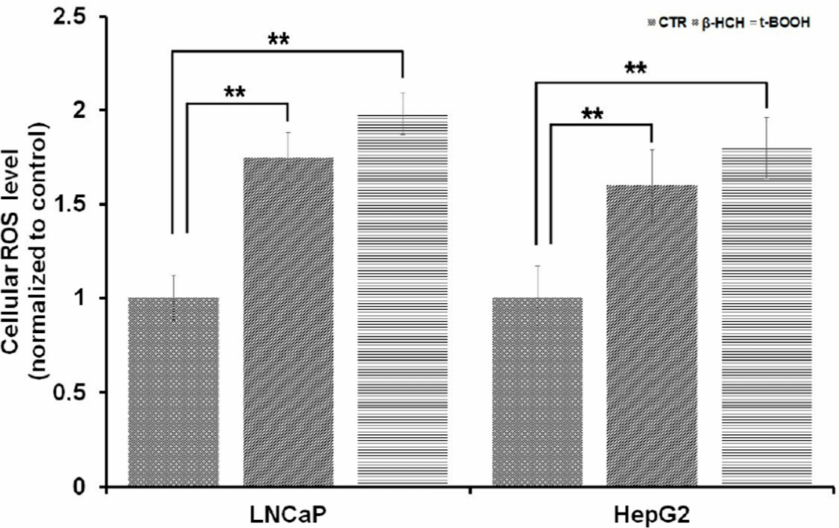
Figure 8. Reactive oxygen species (ROS) production detected by CellROX assay. The histogram shows an approximately two-fold increase in fluorescence intensity in samples treated with 10 µ M β -HCH for 6 h compared to untreated cells. 75 µ M Tert Butyl Hydro peroxide was used as a positive control for ROS induction. Statistically significant di ff erences (** p < 0.01) are marked with